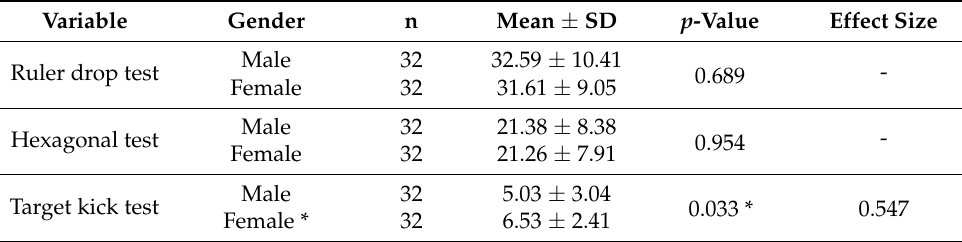
Table 3. Gender differences in the motor coordination tests (n =